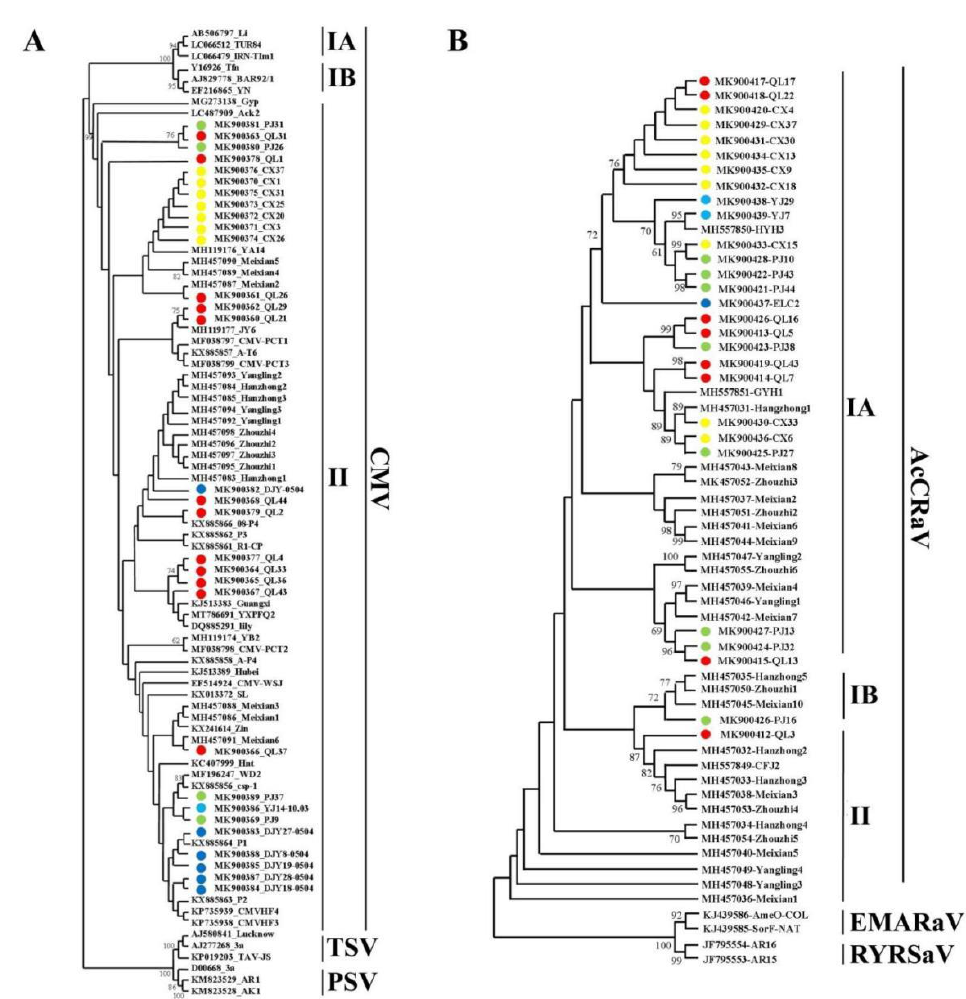
Figure 4. Phylogenetic analysis of CMV ( A ) and AcCRaV ( B ), based on CP genes. Note: Branches with a bootstrap value of > 60% are shown. Light blue represents the Ya’an isolate, green represents the Pujiang isolate, red represents the Qionglai isolate, yellow represents the Cangxi isolate, and dark blue represents the Dujiangyan isolate.